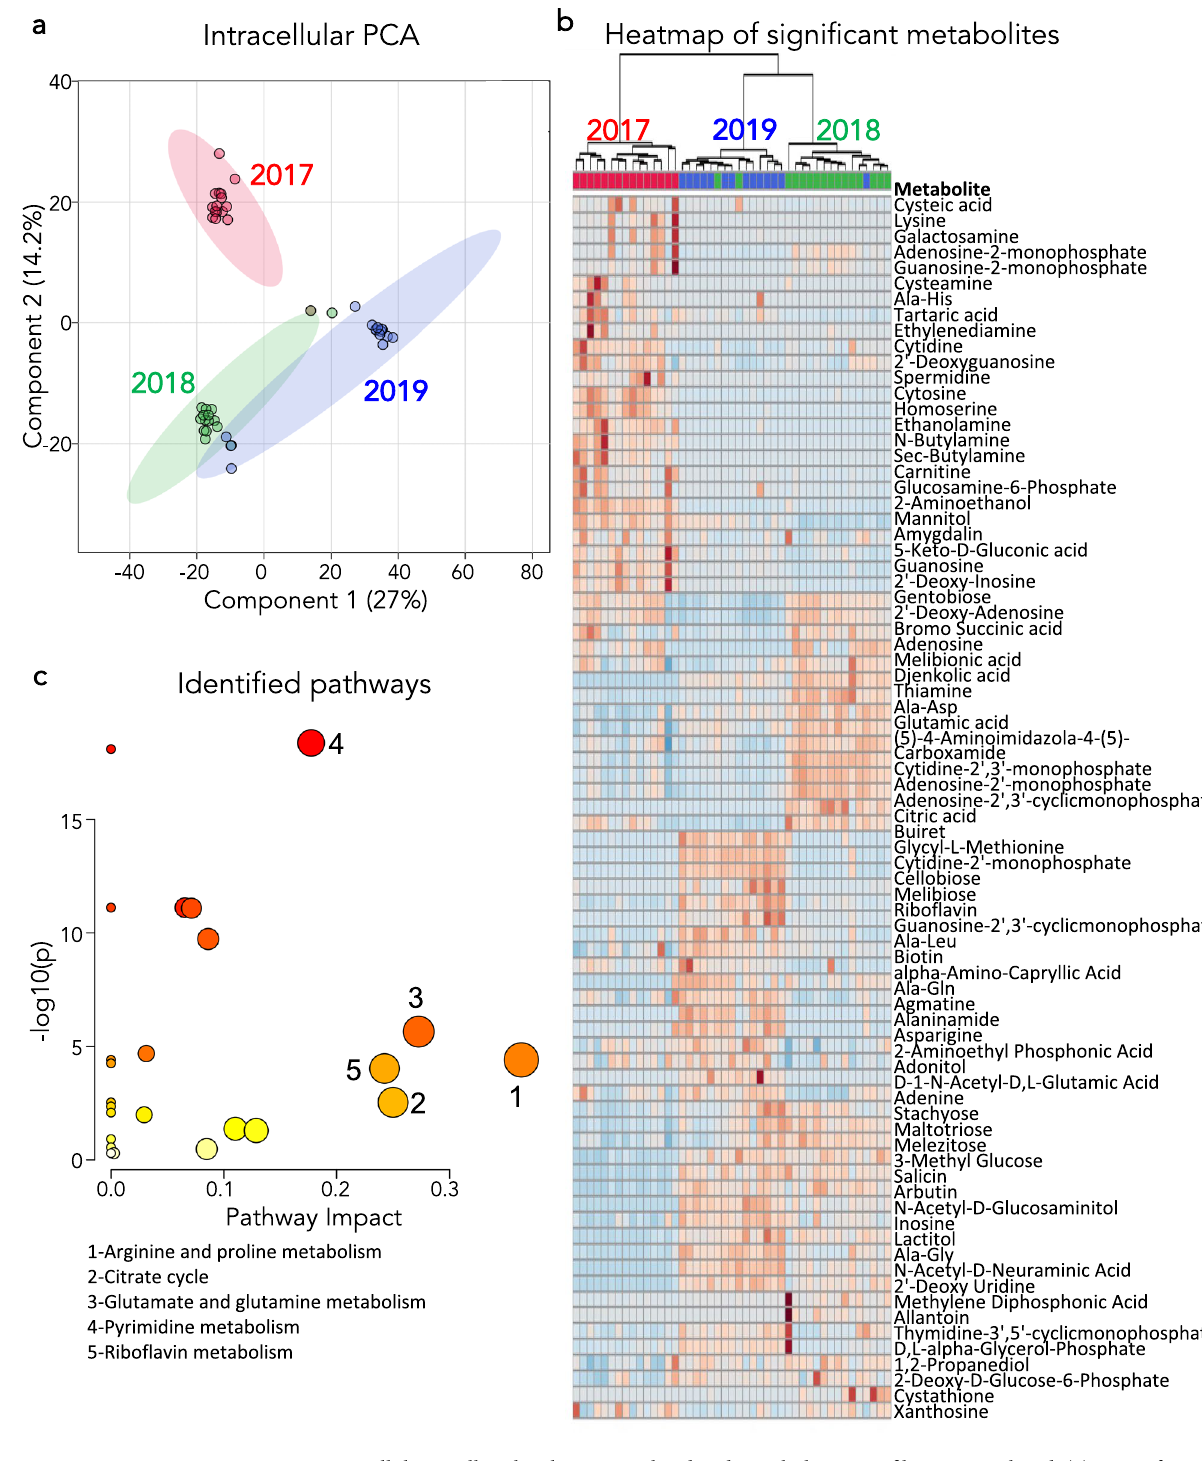
Figure 5. Intracellular small molecules were isolated and metabolomic profiles were analyzed. ( a ) PCA of the intracellular small molecules. Metabolites from 2017 group separately from 2018 and 2019. Metabolites from 2018 and 2019 group independently but overlap in the 95% confidence intervals for several springs, most strongly in FS4 and FS5. ( b ) Heatmap of the significant identified metabolites between years determined using an ANOVA (p < 0.05). Sampling year is indicated at the top of the figure with each column representing one sample and each row representing an identified metabolite. The dendrogram at the top groups 2018 and 2019 separately from 2017 based on the relative abundance of the identified metabolites. The figure was generated using MetaboAnalyst v4.0 ( c ) Metabolic pathways derived from the identified metabolites with the y-axis showing the p-value from an ANOVA of the groups and the x-axis showing the metabolic impact based on the metabolites identified and their role in the specific metabolic